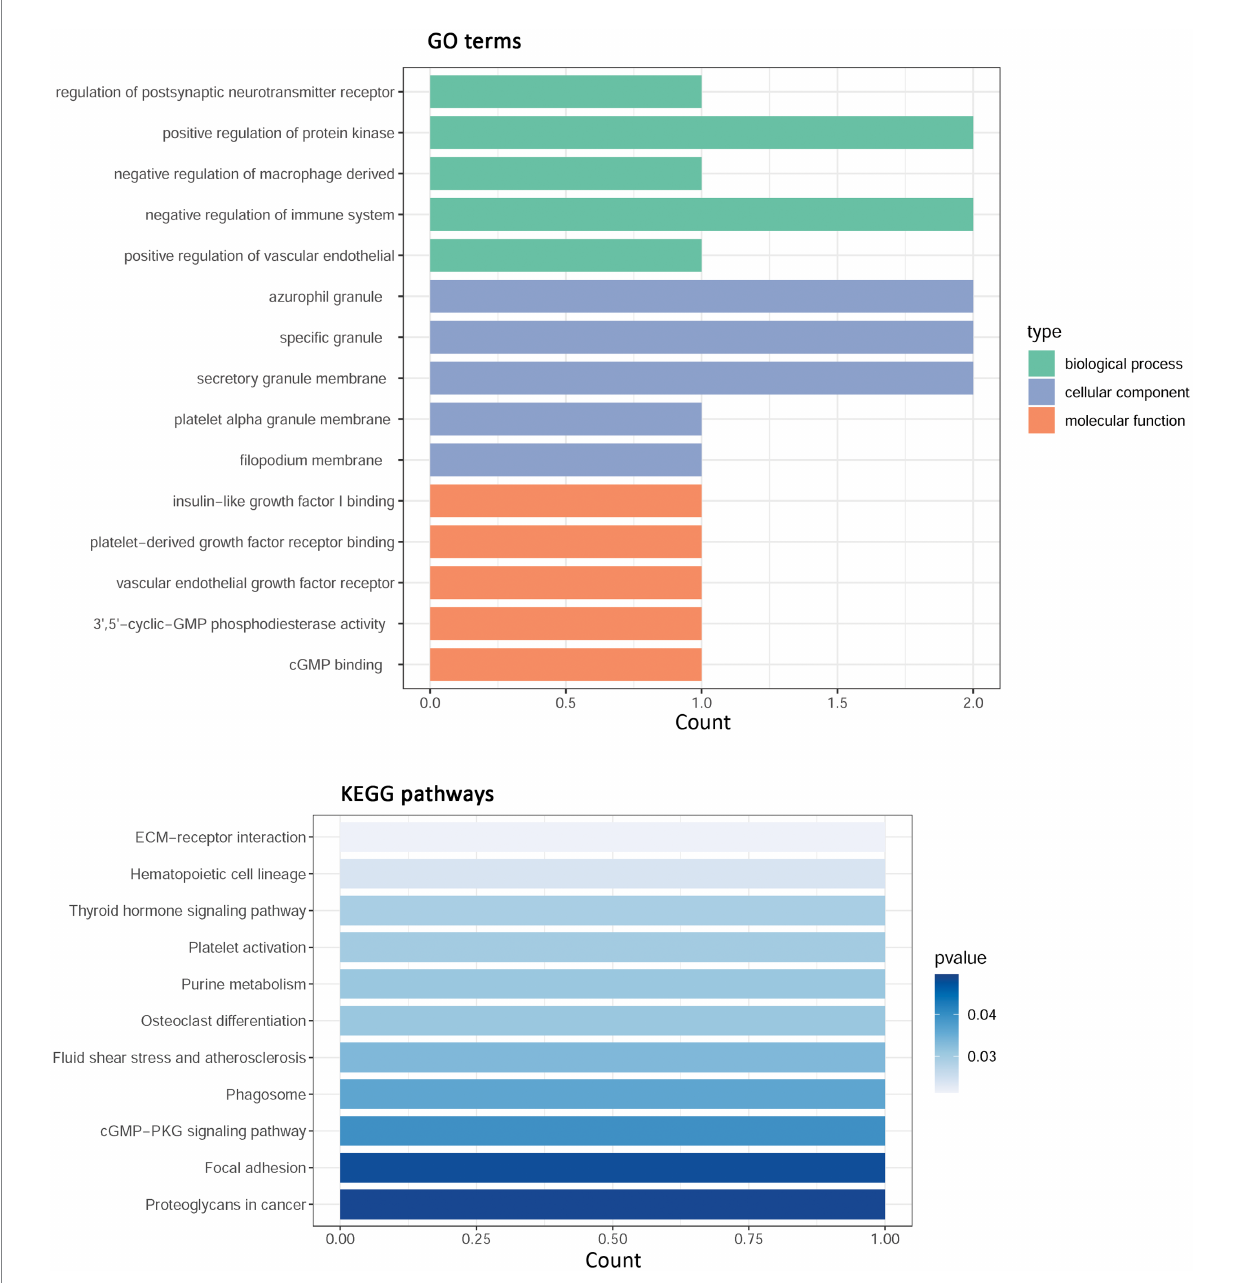
FIGURE 4 Functional enrichment analysis for hub shared genes in IS and COVID-19. IS, ischemic stroke; COVID-19, coronavirus disease 2019; GO, Gene Ontology; KEGG, Kyoto Encyclopedia of Genes and